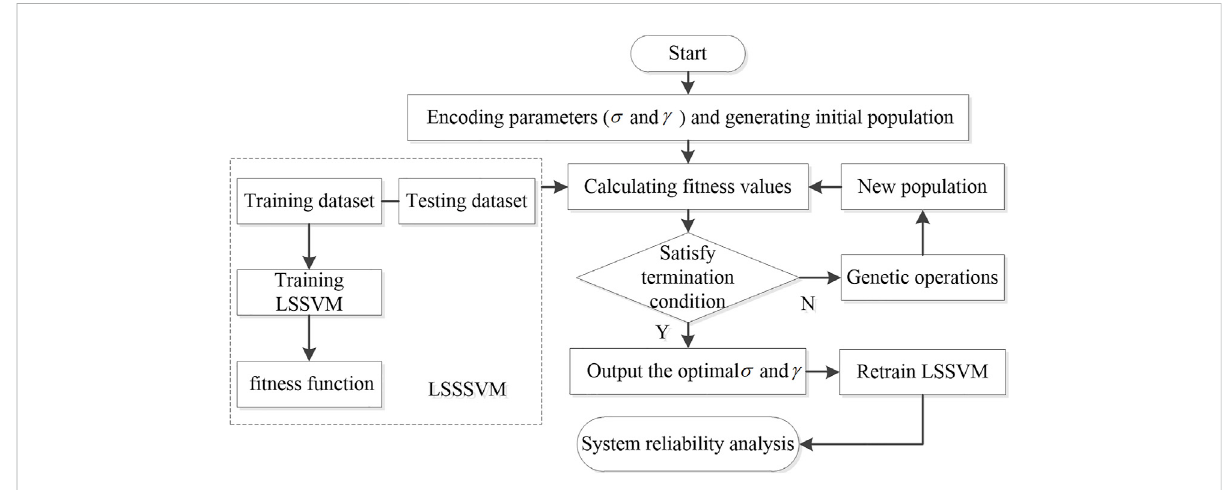
FIGURE 2 Calculation diagram of GA optimized LSSVM in system reliability analysis of